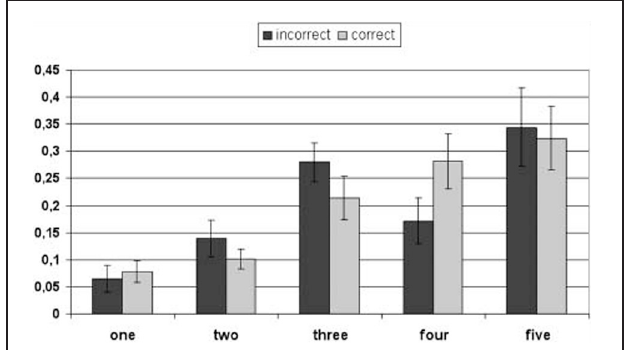
FIGURE 1 | Percentages of children’s fixation times for the confidence scale (smileys one to five). The relative fixation times are separately reported for correctly and incorrectly answered items. Error bars indicate standard errors of the means.